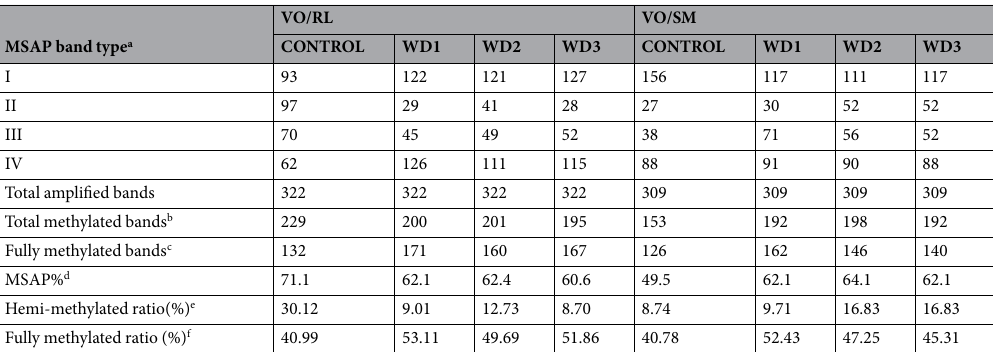
Table 1. Different types of MSAP within the levels of methylated cytosine for Valencia Orange/Rangpur lime (VO/RL) and Valencia Orange/Sunki Maravilha (VO/SM) exposed to full irrigation (Control) and to the severe conditions of recurrent water deficit (WD1, WD2 and WD3). a Type I is the presence of bands in both EcoRI/HpaII and EcoRI/MspI enzymes and indicates the absence of methylation; type II are bands generated in EcoRI/HpaII enzymes but not in EcoRI/MspI enzymes; type III bands appear in EcoRI/MspI enzymes but not in EcoRI/HpaII enzymes; and type IV represents the absence of band in both enzyme combinations. b Total methylated bands are II + III + IV bands. c Fully methylated are III + IV bands. d MSAP is a percentage ratio of total methylated bands (II + III + IV) to total amplified bands. e Hemi-methylated ratio is a percentage ratio of total hemi-methylated bands (II) to total amplified bands. f Fully methylated ratio is a percentage ratio of fully methylated bands (III + IV) to total amplified